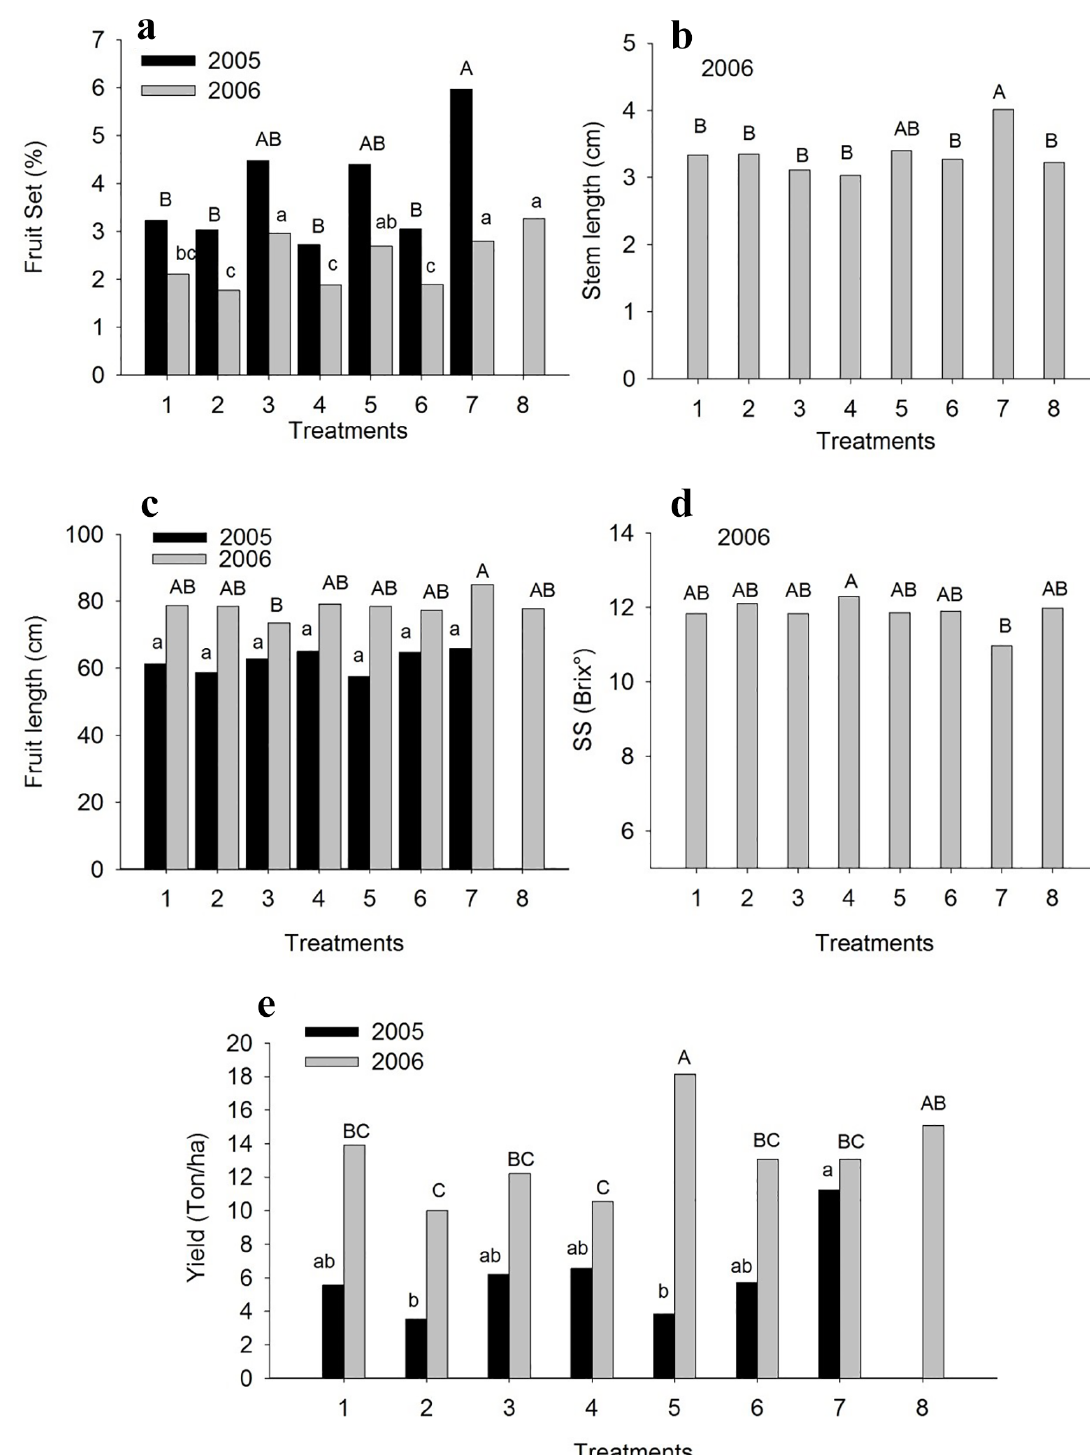
Figure 1 - Effect of foliar applied boron at different concentrations and plant growth regulators on fruit set ( a ), average stem length ( b ), fruit length ( c ), soluble solids (SS) ( d ) and yield ( e ) of ‘Garber’ pear trees, in the growing seasons of 2004/05 and